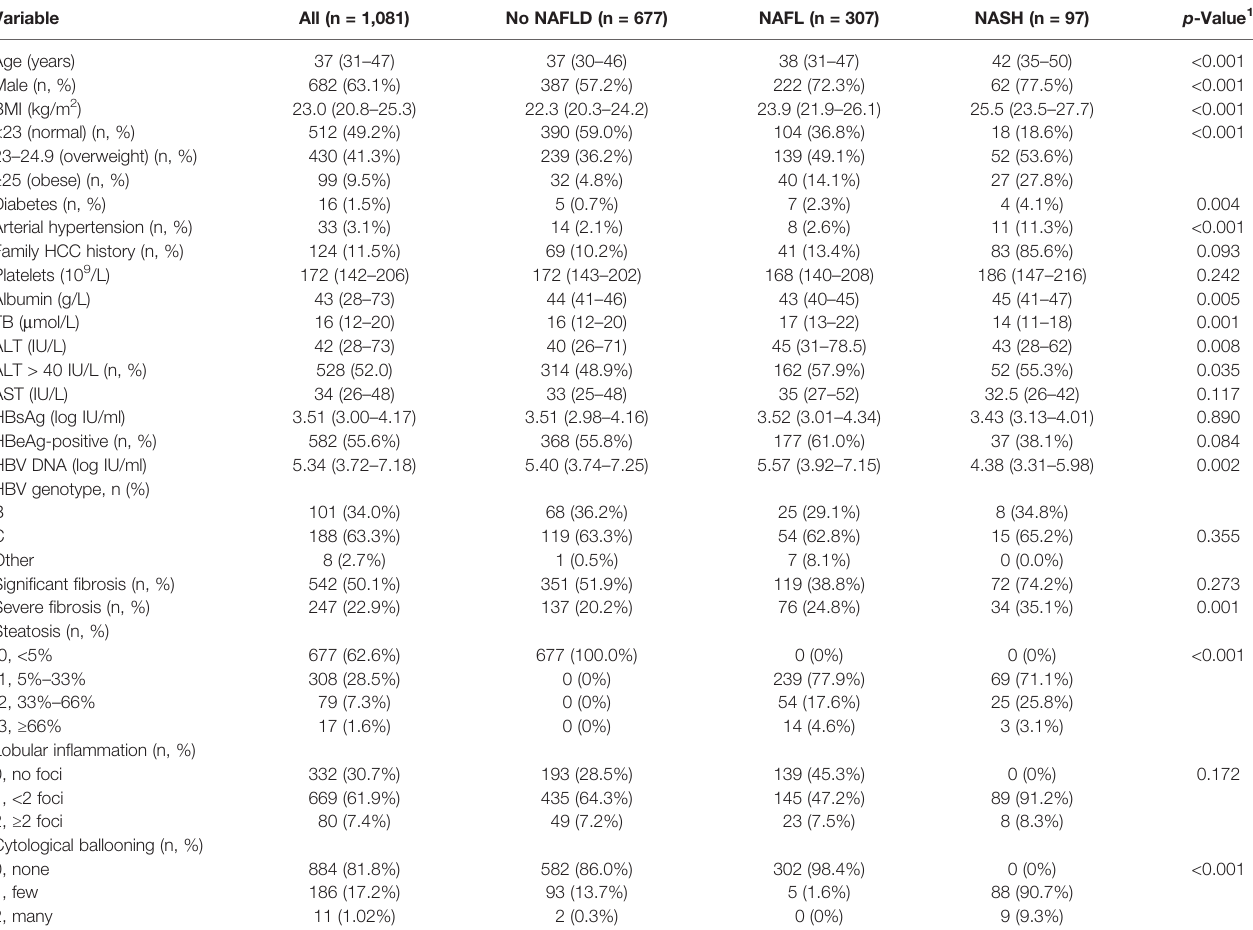
TABLE 1 | Demographic, clinical, and biochemical characteristics and liver pathological features of the patient population. Variable All (n =